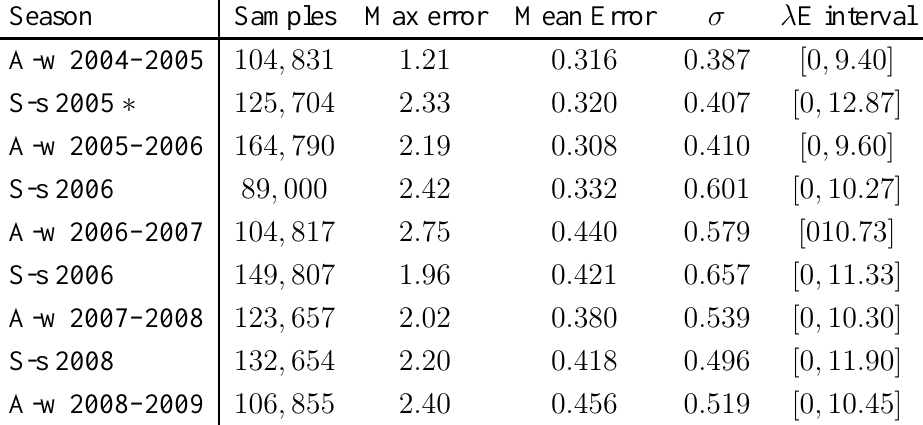
Table 7. Nonlinear virtual sensor minimum mean square error in g m − 2 min − 1